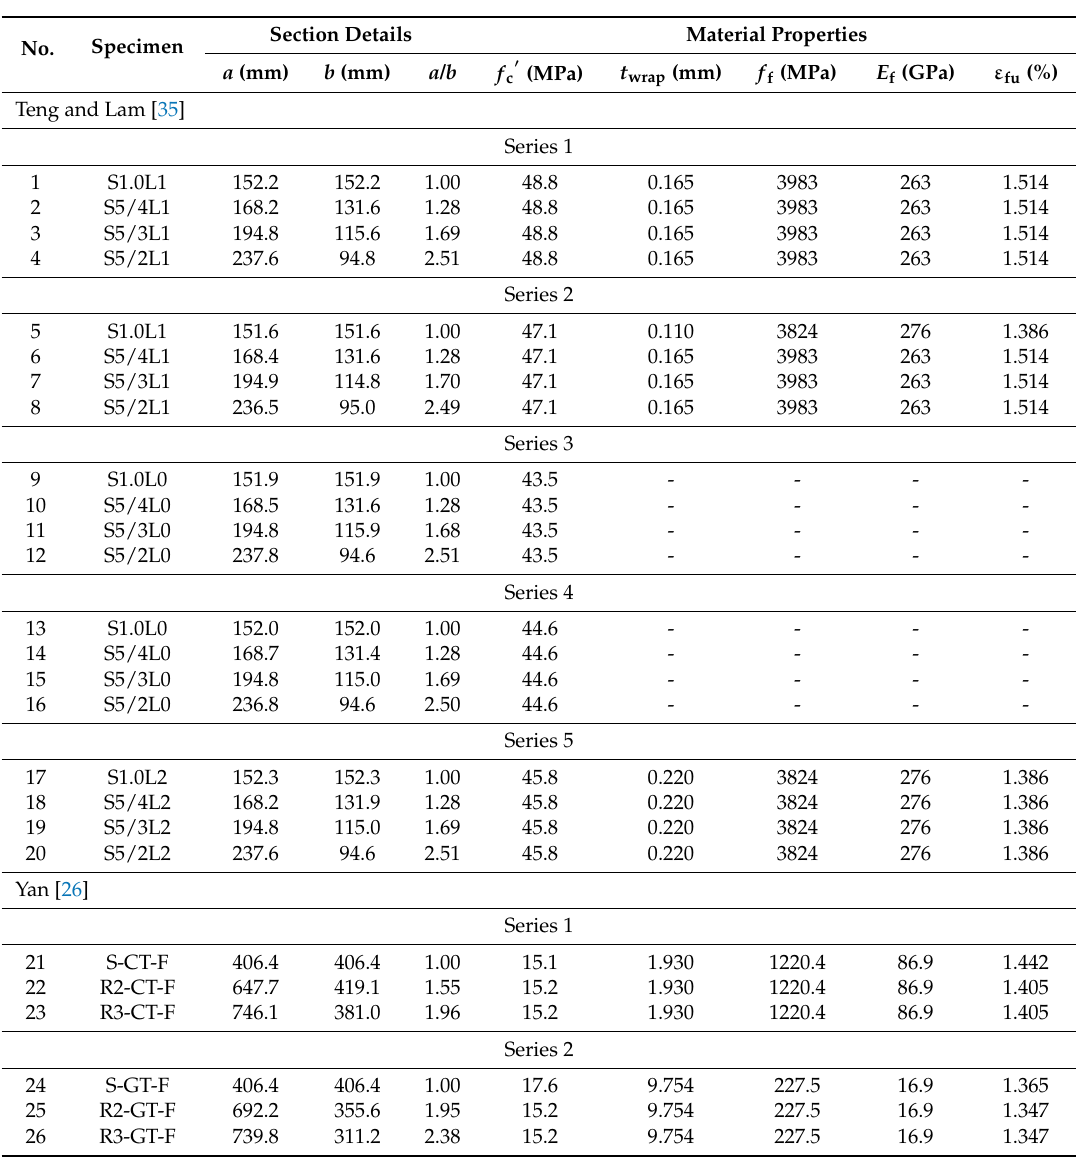
Table 1. Summary of fiber-reinforced polymers (FRP) reinforcement, material, and mechanical properties of test